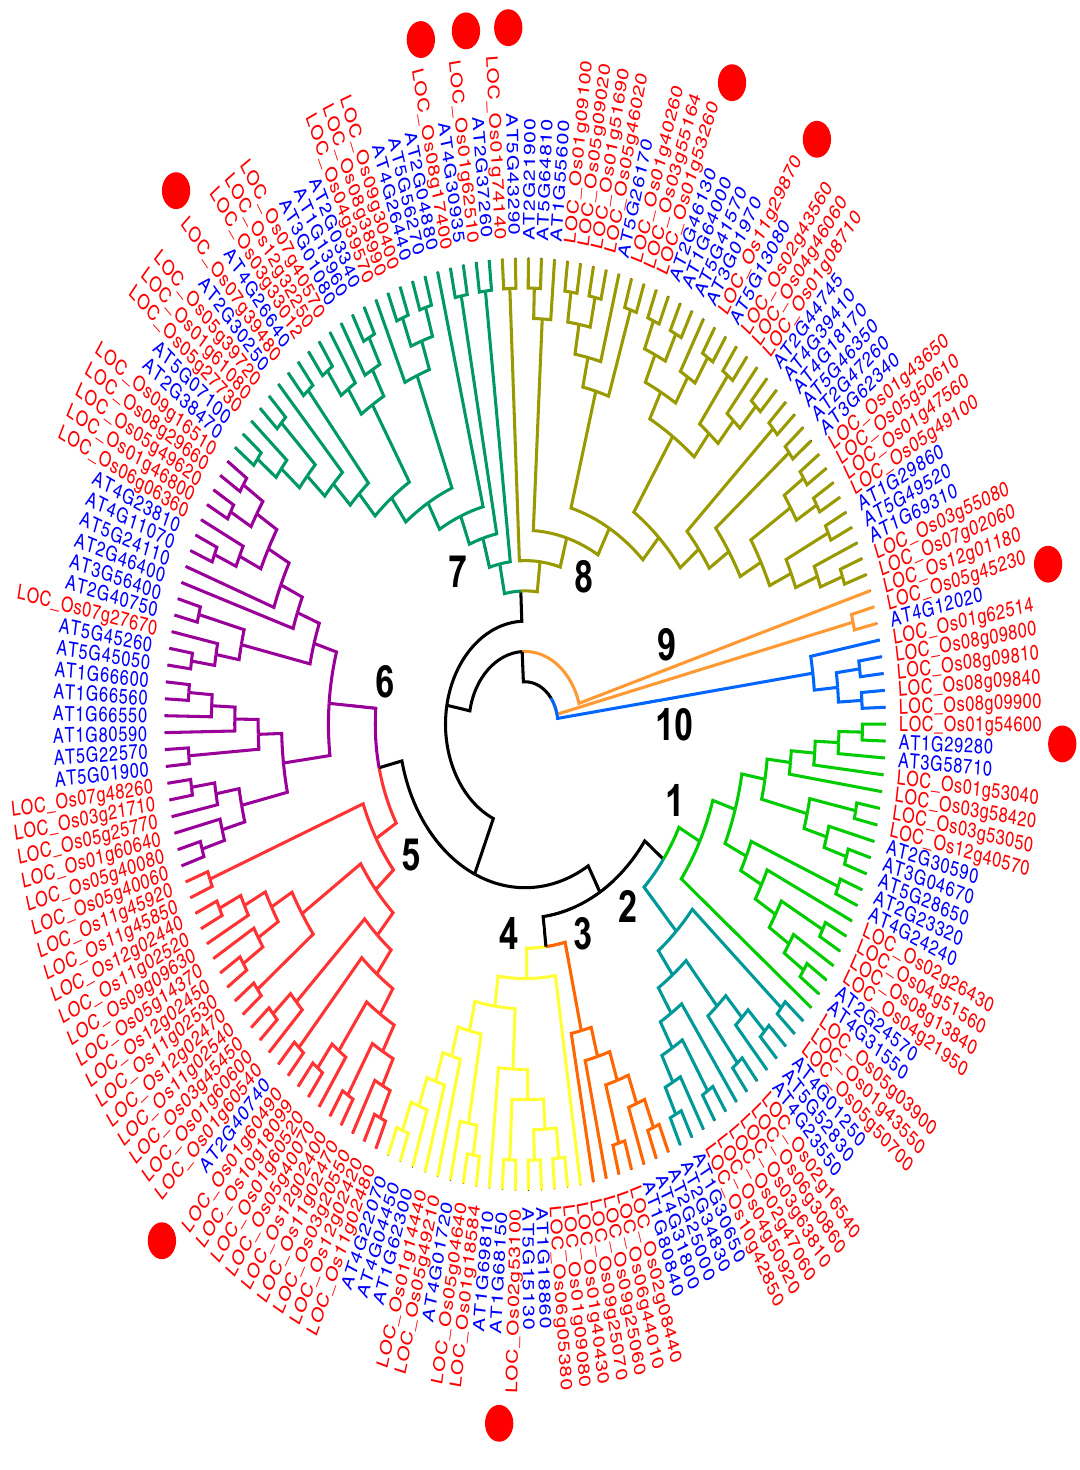
Figure 1. Phylogenetic tree of collated rice and Arabidopsis full-length WRKY protein sequences. Red dots represent the rice-Arabidopsis orthologous gene pairs. The tree is built using the neighbor-joining (NJ) method (MEGA7.0 software) and are divided into ten clades, numbered in